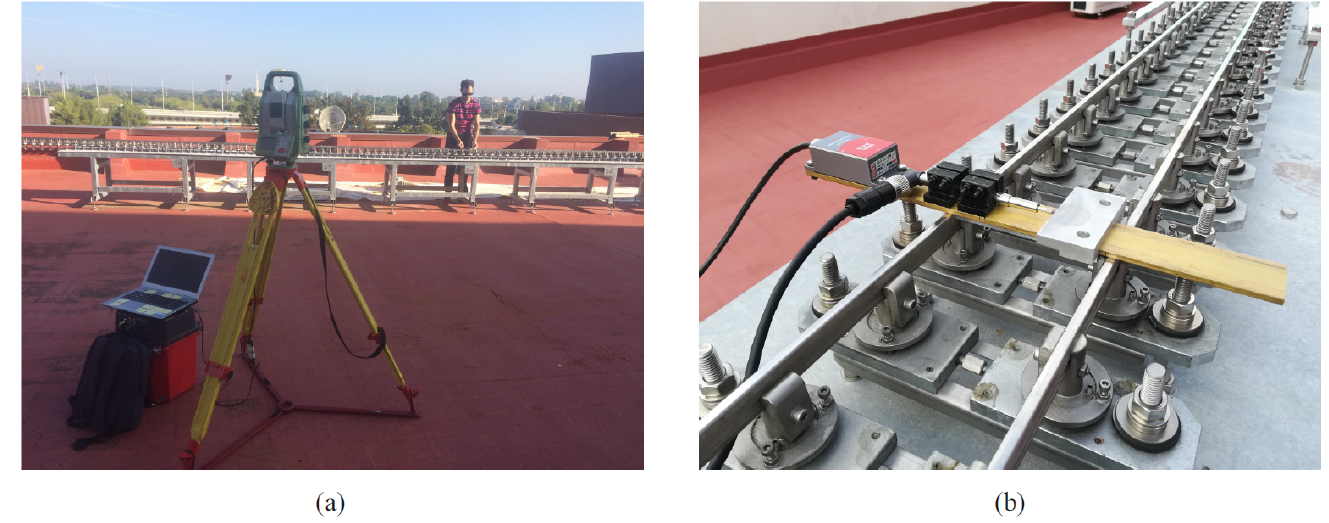
Figure 15. Irregularity measurement. ( a ) Robotic total station, ( b ) LVDT and